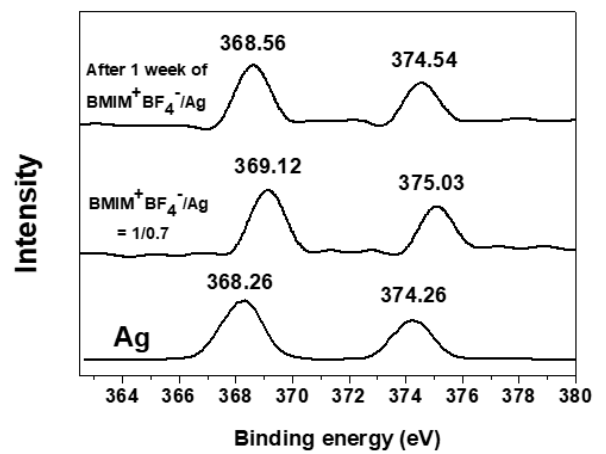
− / Ag composites after preparation and after 1 4